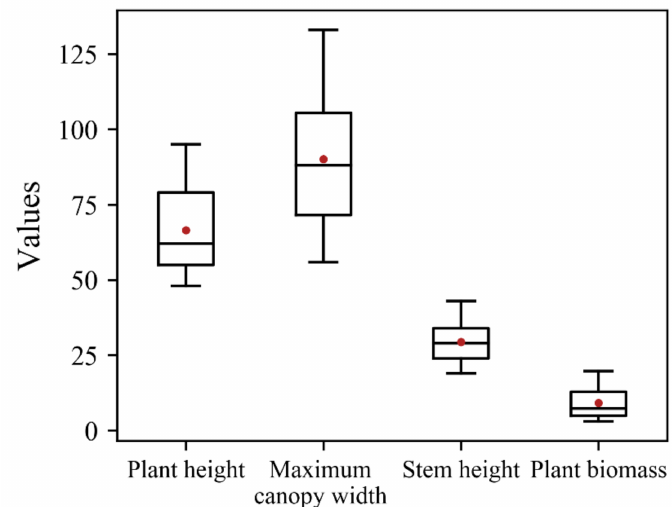
Figure 3. Box plots of the measured values of plant height, maximum canopy width, stem height, and plant biomass. The unit of plant height, maximum canopy width, and stem height was cm, and the unit of plant biomass was g.